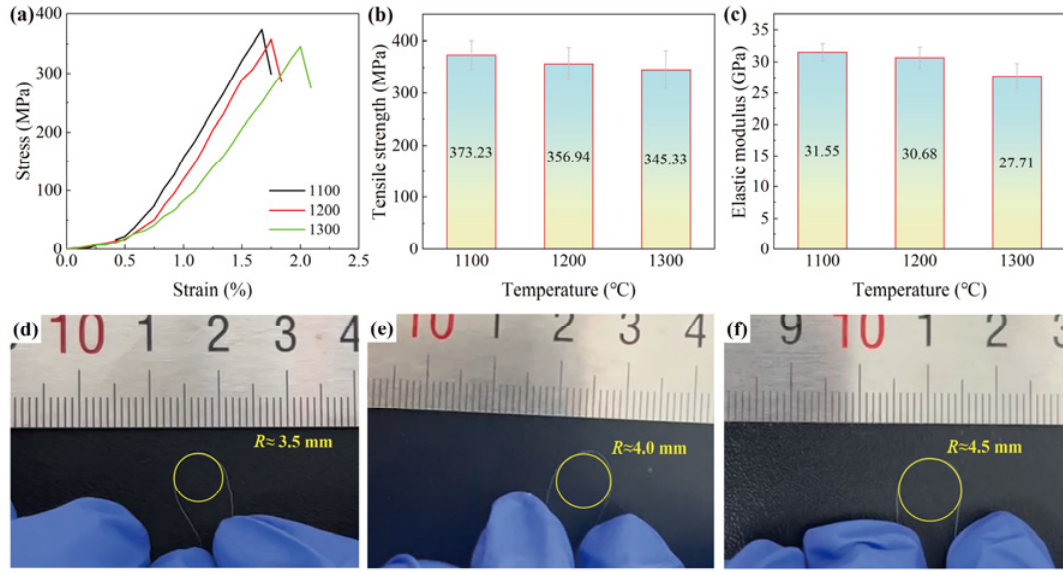
Fig. 10 (a) Stress–strain curves, (b) tensile strengths, (c) elastic moduli, and limit radii of curvature of Lu 2 O 3 continuous fibers: (d) PAWVT-145–1100, (e) PAWVT-145–1200, and (f)